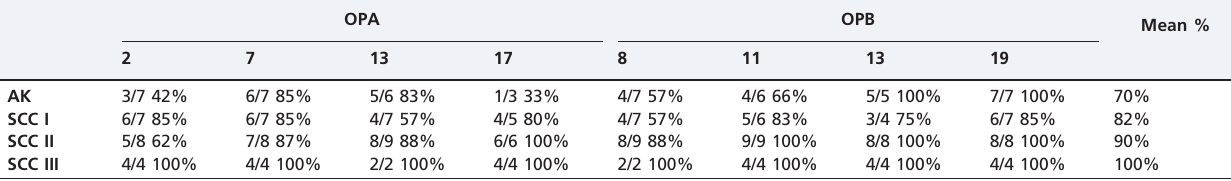
Table 3 - The RAPD patterns were significantly altered in the tumors compared with the normal tissues (%): AK x